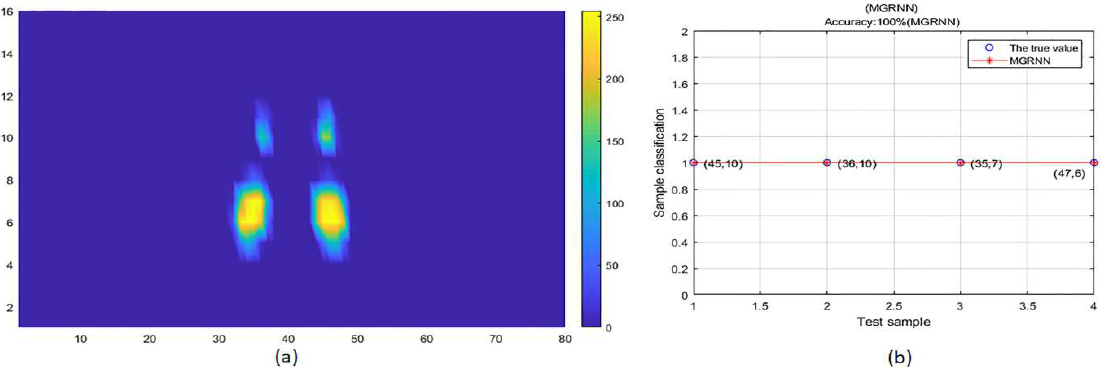
Figure 21. Four interference sources with same frequency at 1 GHz. ( a ) original image; ( b ) result of classification.